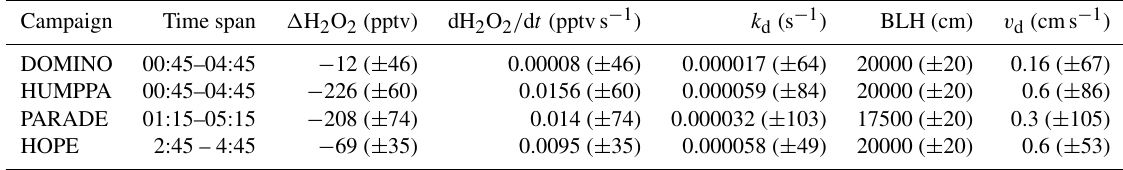
Table 2. Calculation of the nighttime dry deposition loss rate k d and the deposition velocity v d . Uncertainties are reported in %. Campaign Time span